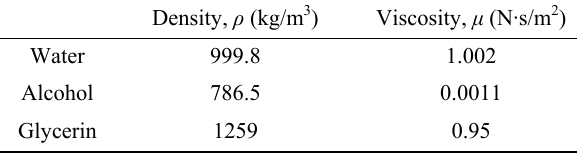
Table 1 Characteristics of the tested liquids at 20 °